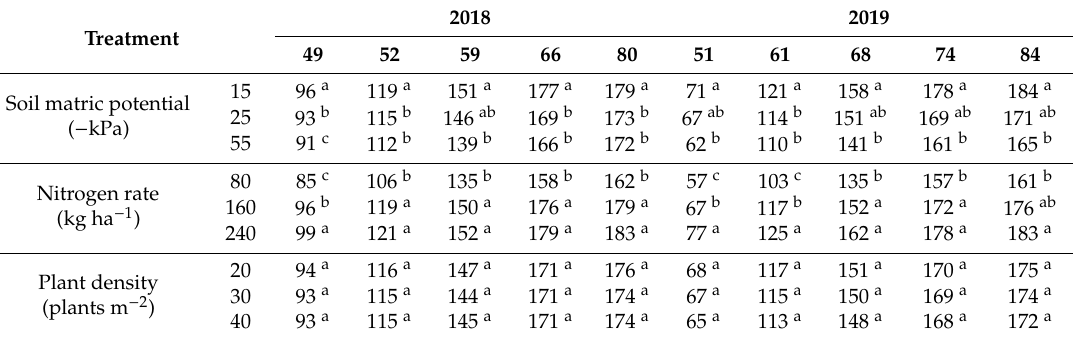
Table 4. E ff ects of soil matric potential, nitrogen application rate, and plant density on quinoa height (cm) at 49, 52, 59, 66, and 80 days after sowing (DAS) in 2018 and at 51, 61, 68, 74, and 84 DAS in 2019.